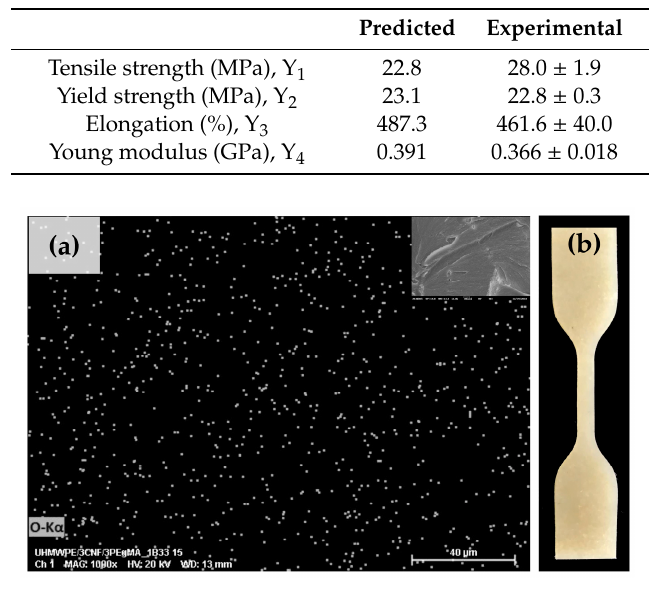
anhydride-grafted-polyethylene. Letters a and b indicate significant di ff erence based on statistical analysis ( p <